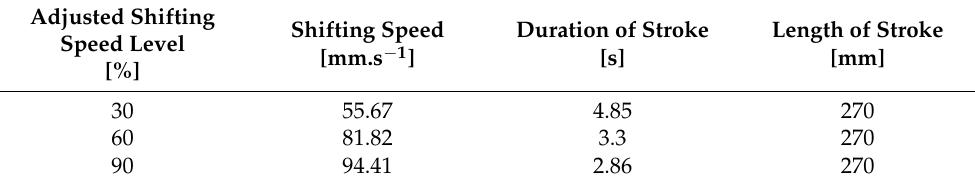
Table 2. Combinations of conditions for all the performed measurements of the reaction forces acting on the driving mechanism.